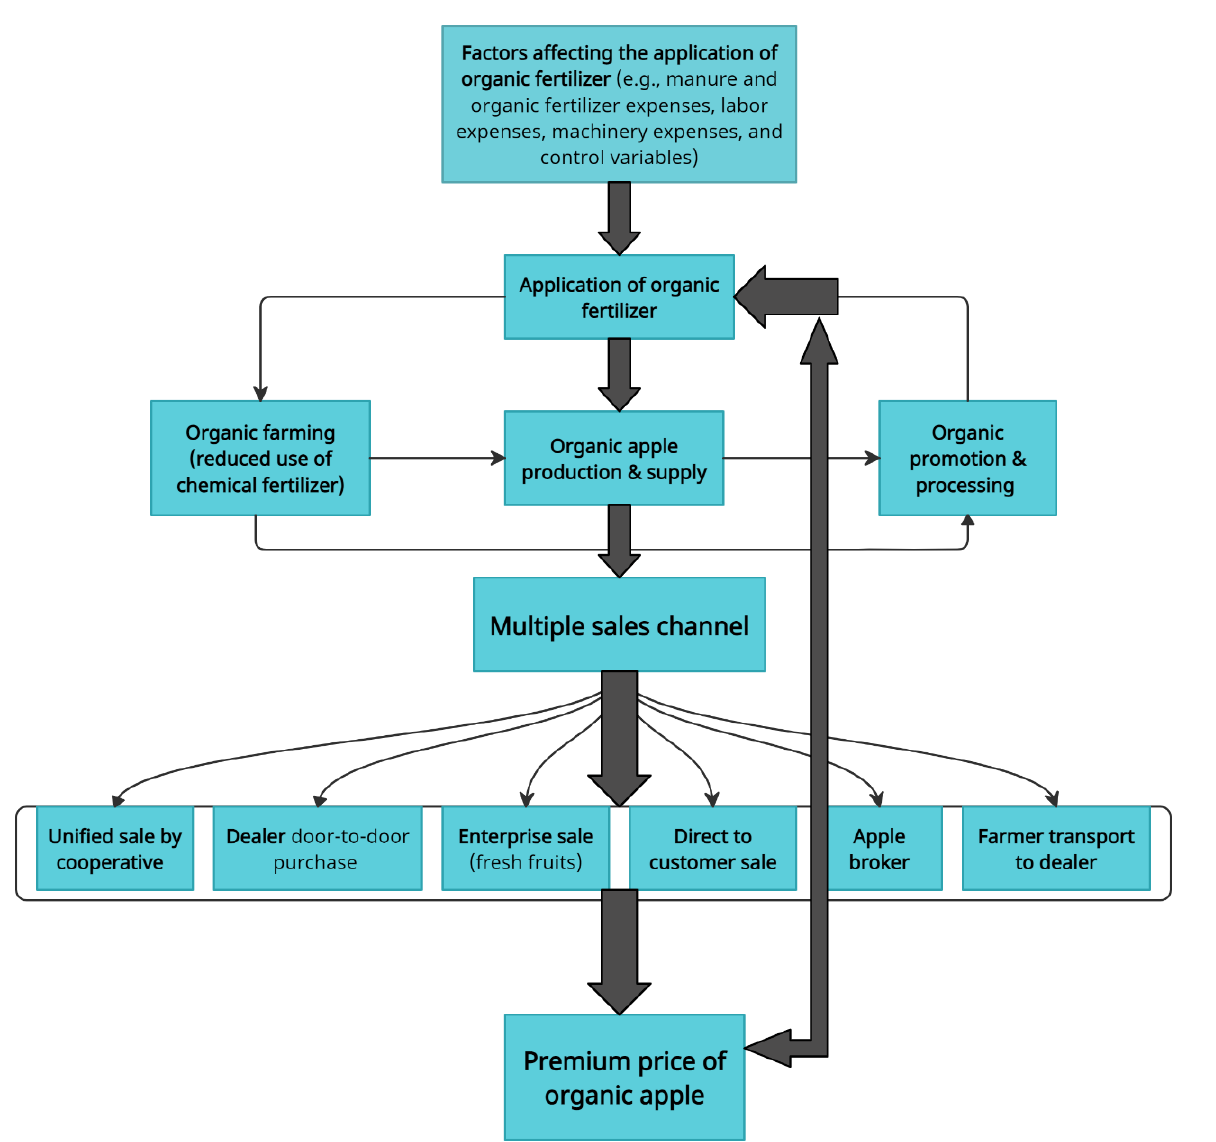
Figure 1. Conceptual framework of the application of organic fertilizer at farm level.